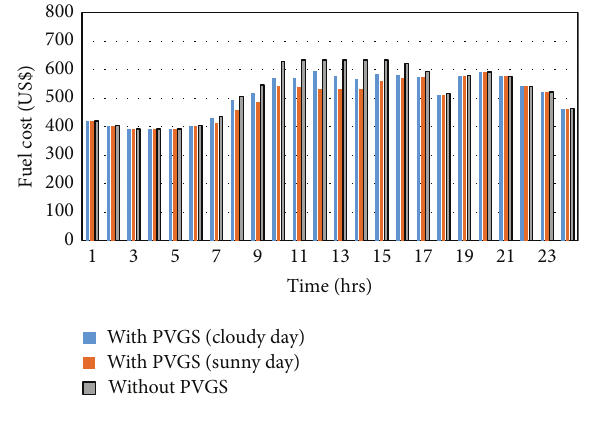
Figure 14: Hourly fuel cost with and without PVGS.